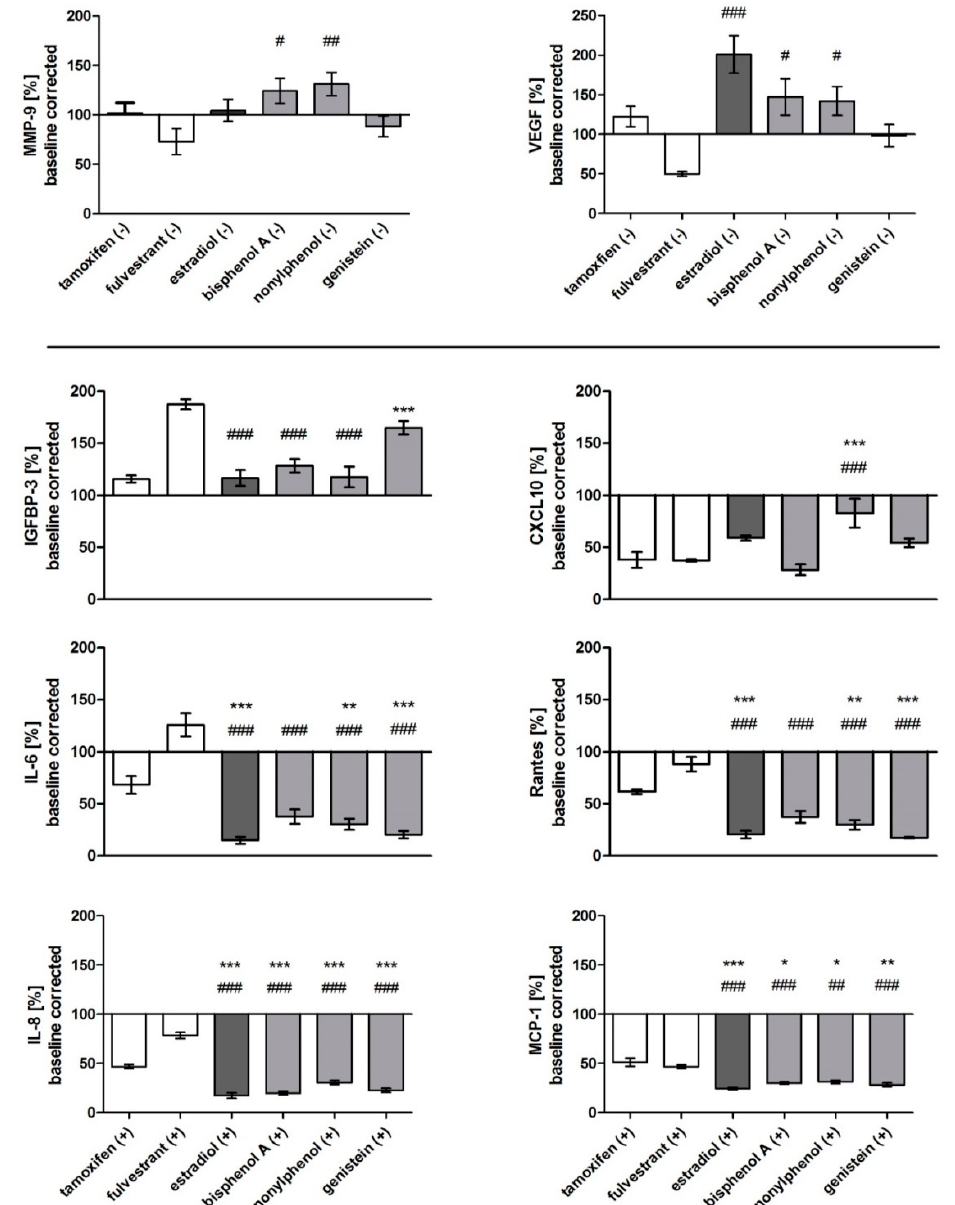
Figure 5. Relative secretion of MMP-9, VEGF, IGFBP-3, CXCL10, IL-6, Rantes, IL-8, and MCP-1 after exposure to estrogen receptor agonists (estradiol, BPA, nonylphenol, genistein) and antagonists (fulvestrant, tamoxifen) without (-) or with (+) stimulation by IL-1ß for 48 h. Data are baseline-corrected and plotted as means ± SEM in percent to the C0 control. Significance against tamoxifen (*) and fulvestrant (#) was tested for n = 6 using a one-way-ANOVA and a Bonferroni multiple comparison post-hoc test for alpha = 0.05 (p ≤ 0.05 (*), p ≤ 0.01 (**), p ≤ 0.001 (***)).